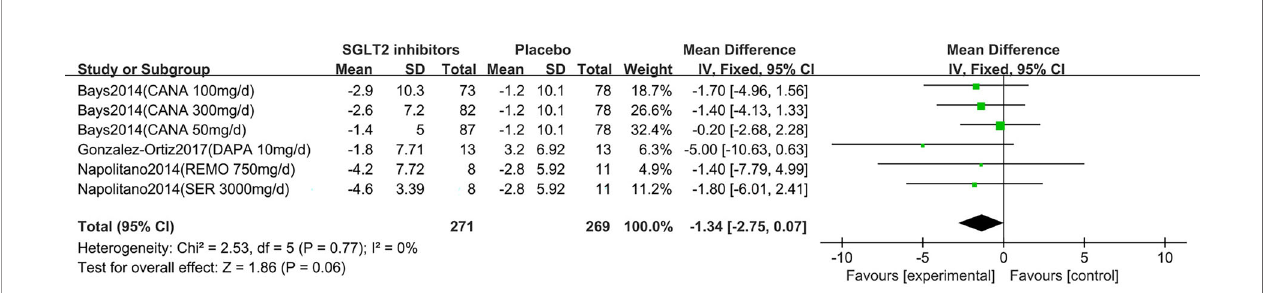
FIGURE 6 | Changes of waist circumference in patients receiving SGLT2 inhibitors versus placebo. CI, con fi dence interval; IV, inverse variance; SD, standardized